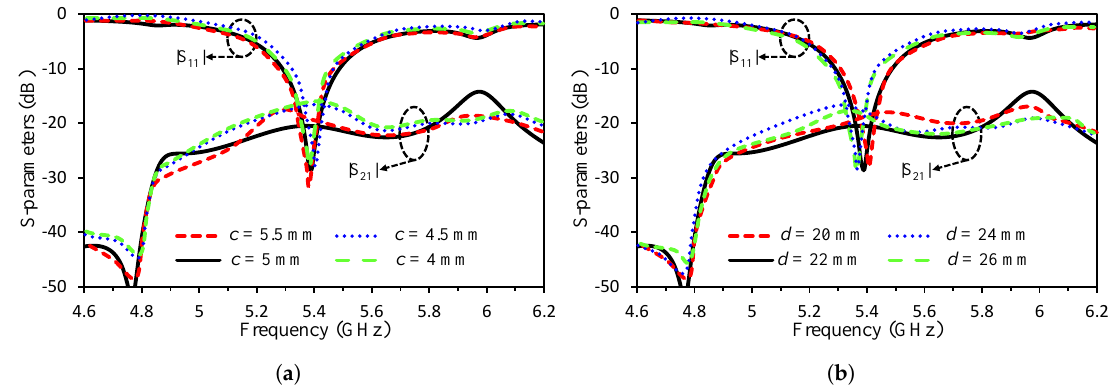
Figure 7. Parametric analysis of the decoupling structure by varying ( a ) c and ( b ) d